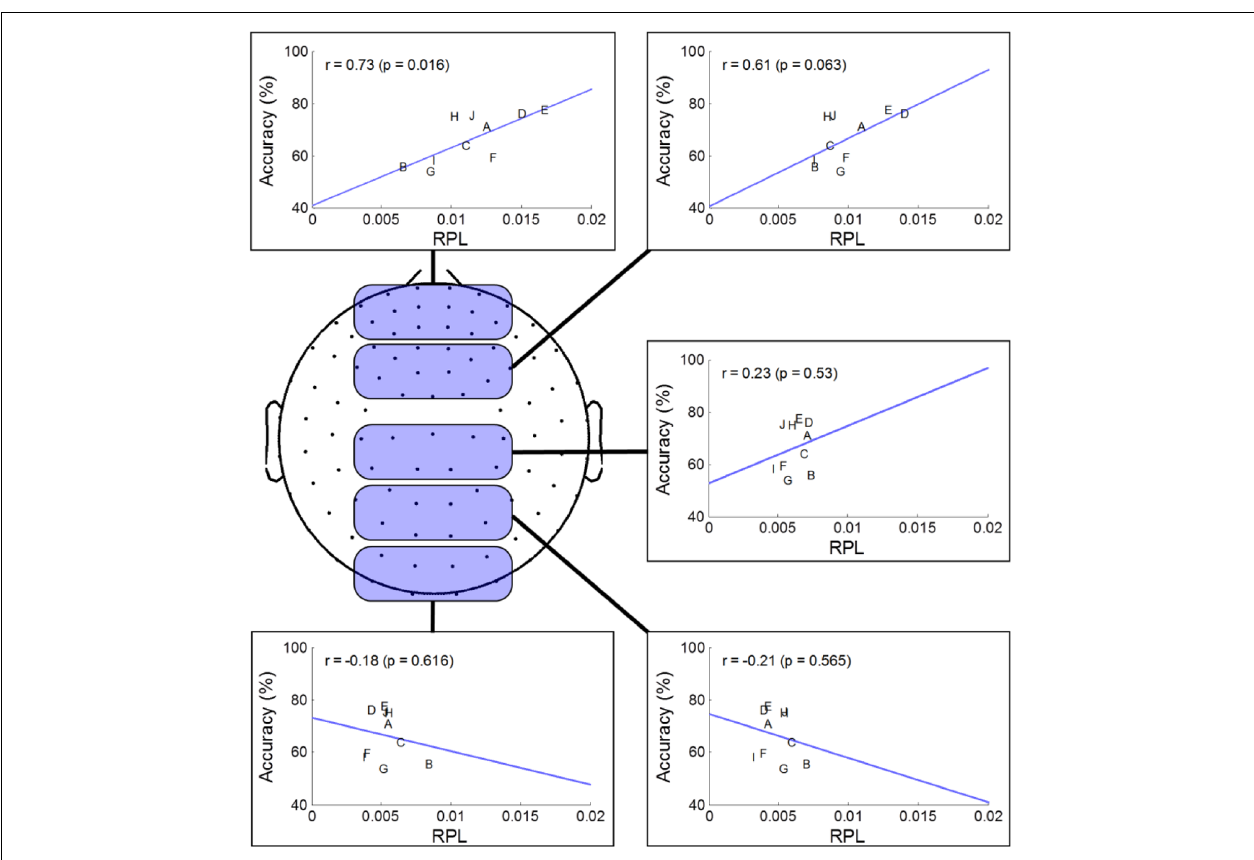
FIGURE 4 | Regional analysis of MEG gamma. The selected channels in each region are marked as shaded round squares and their mean gamma RPL is plotted against MI accuracy.The direction of the fitted line and the correlation coefficient changed from the prefrontal to occipital areas.